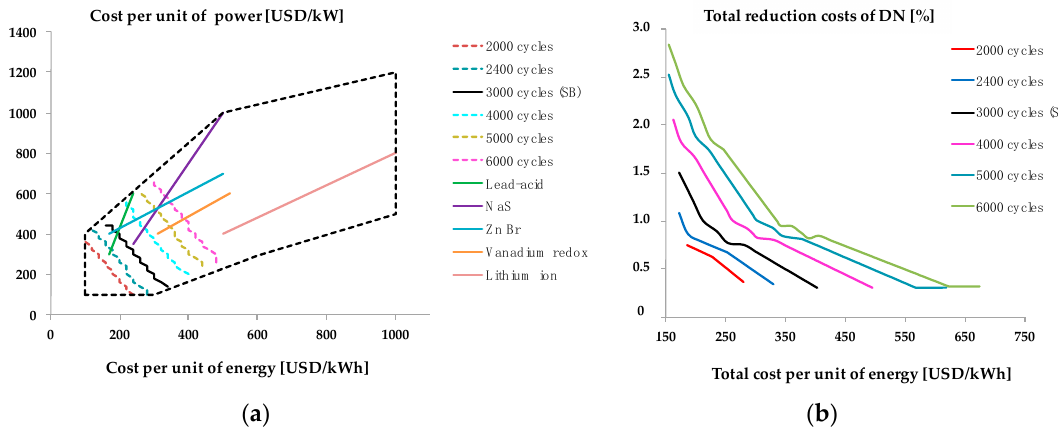
Figure 7. ( a ) Effects of the BESS life span on the break-even costs and ( b ) Total cost reductions for the DN for different life cycles of the BESS.